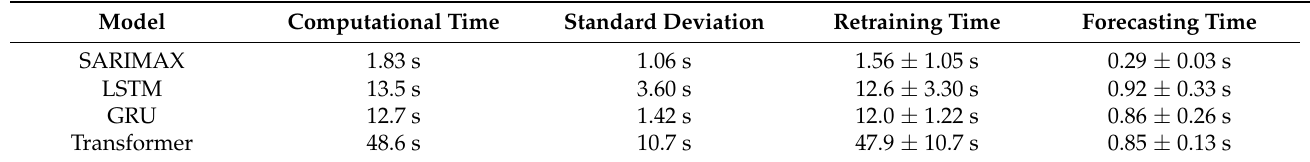
Table 5. Time costs for the training and forecasting (of 7 days) mean for each model, averaged based on 10 participants.